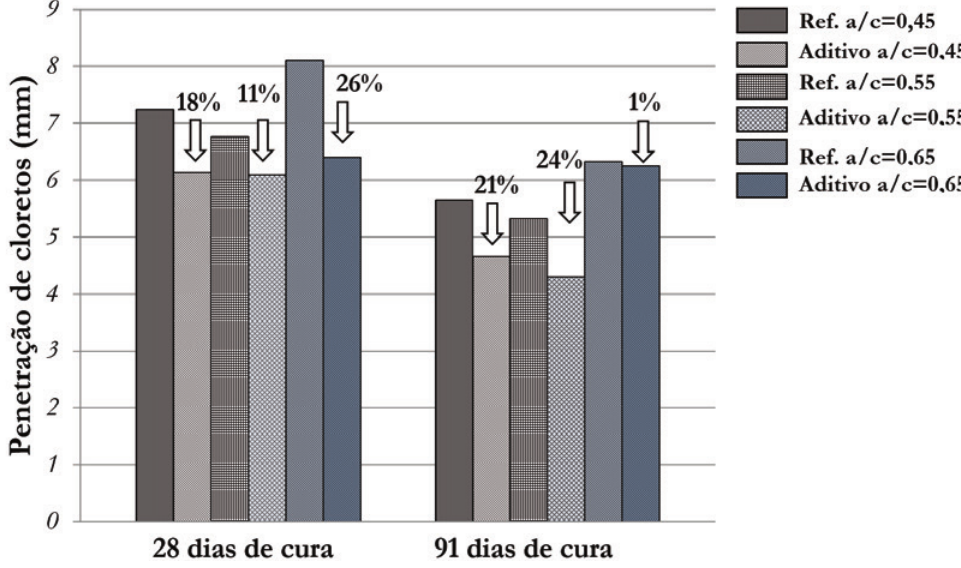
Penetração de cloretos nas amostras de